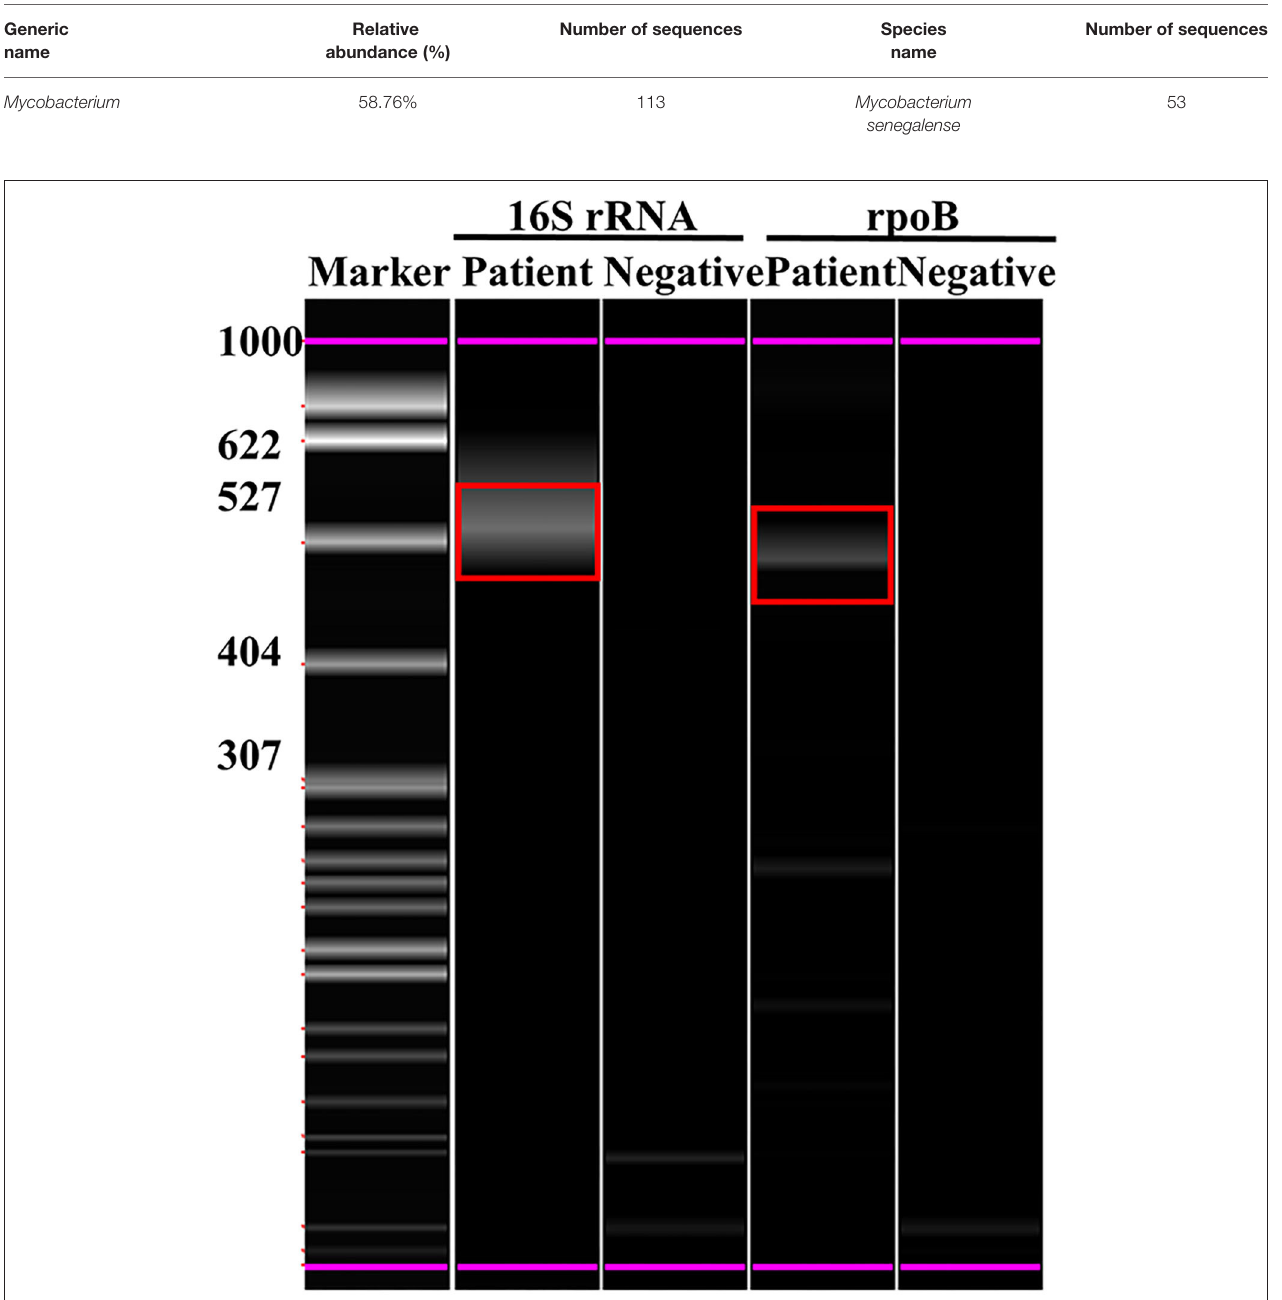
FIGURE 3 | Polymerase chain reaction and capillary electrophoresis technique confirmed M. senegalense infection in the patient. 16S rRNA- and rpoB -specific amplified fragments are marked with red boxes.